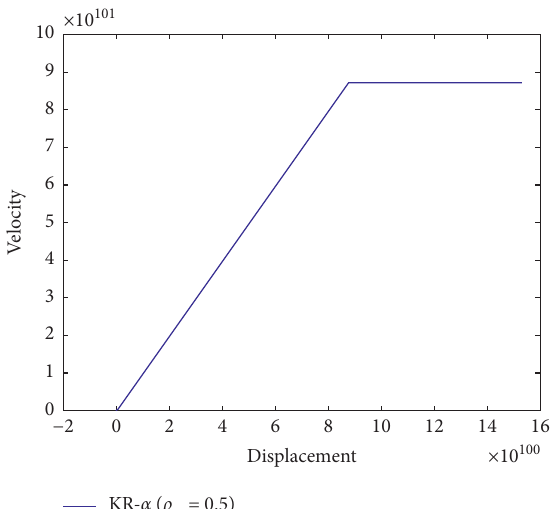
Figure 29: Phase portrait of the hardening spring calculated using the KR- α method ( ρ